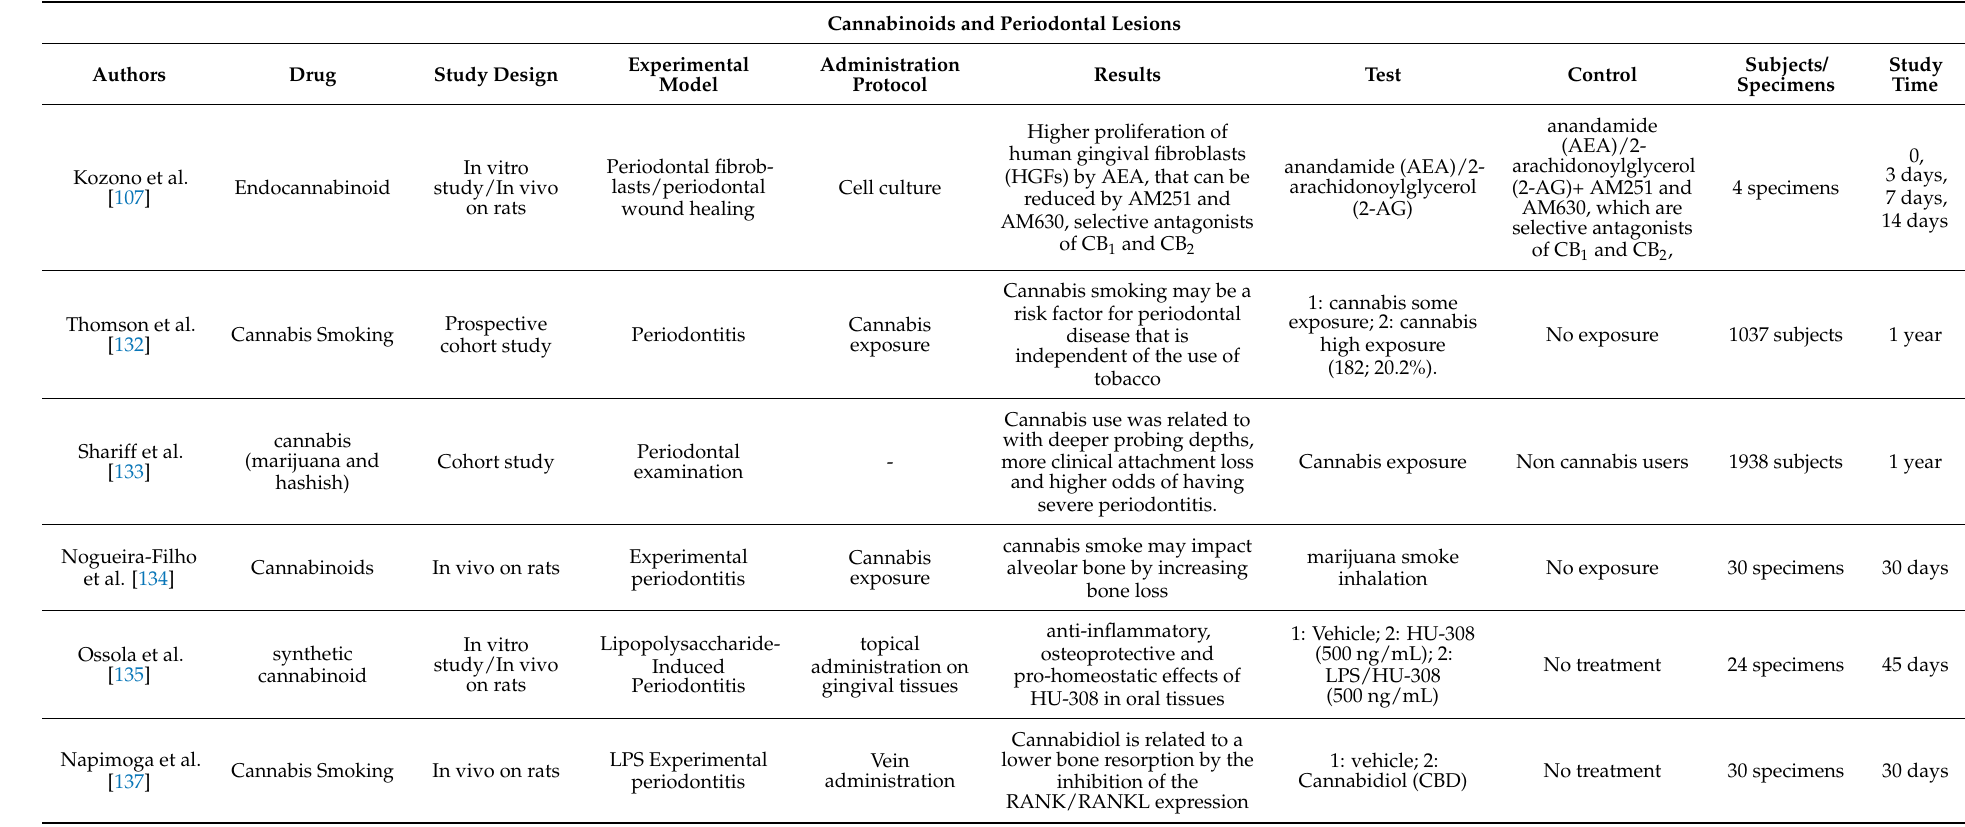
Table 5. Summary of the studies included according to the cannabinoids and periodontal